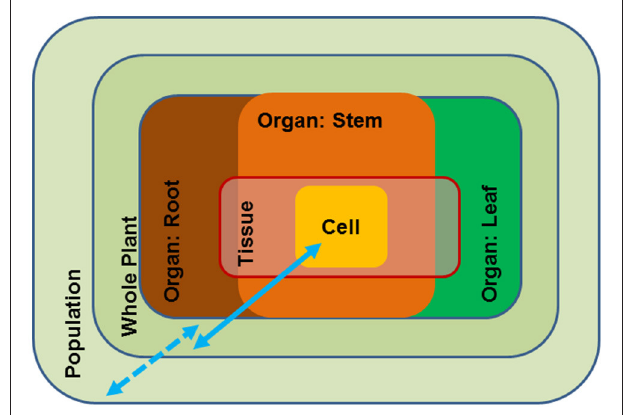
FIGURE 1 | Schematic overview of the different scales of drought impact from the cellular to the population level. Blue arrows: full line (scale of molecular and physiological traits), broken line (scale of ecological